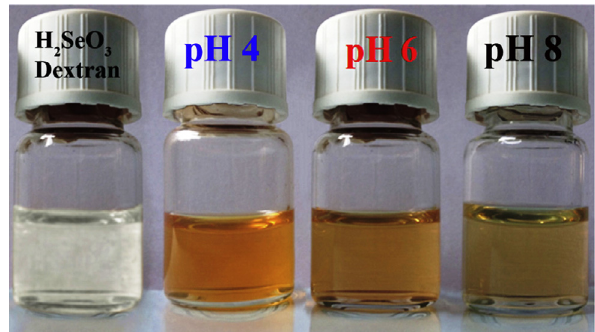
Figure 3: Photograph of un - irradiated H 2 SeO 3 /Dex solution and the gamma irradiation synthesized of SeNPs/Dex solutions at dose of 25 kGy and at di ff erent pHs ( 4, 6, and 8 ) ref. [ 31 ] ; Copyright 2018, Elsevier.